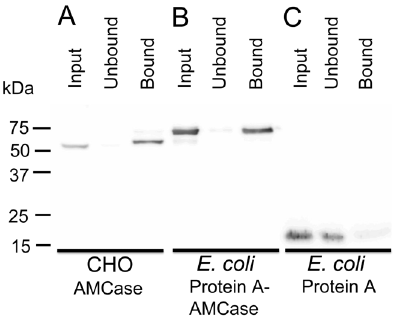
Figure 5. Binding analysis of CHO-expressed or E. coli - produced AMCase to chitin beads. (A) CHO-expressed AMCase- V5-His, (B) E. coli -produced Protein A-AMCase-V5-His, (C) E. coli - produced Protein A. Chitin-binding assays using chitin beads were carried out as described in the Materials and Methods section. The recombinant fusion with the chitin-binding domain (CBD) of AMCase bound to the chitin beads (A and B), and the fusion protein without the chitin-binding domain bound to the chitin beads (C), indicating that the